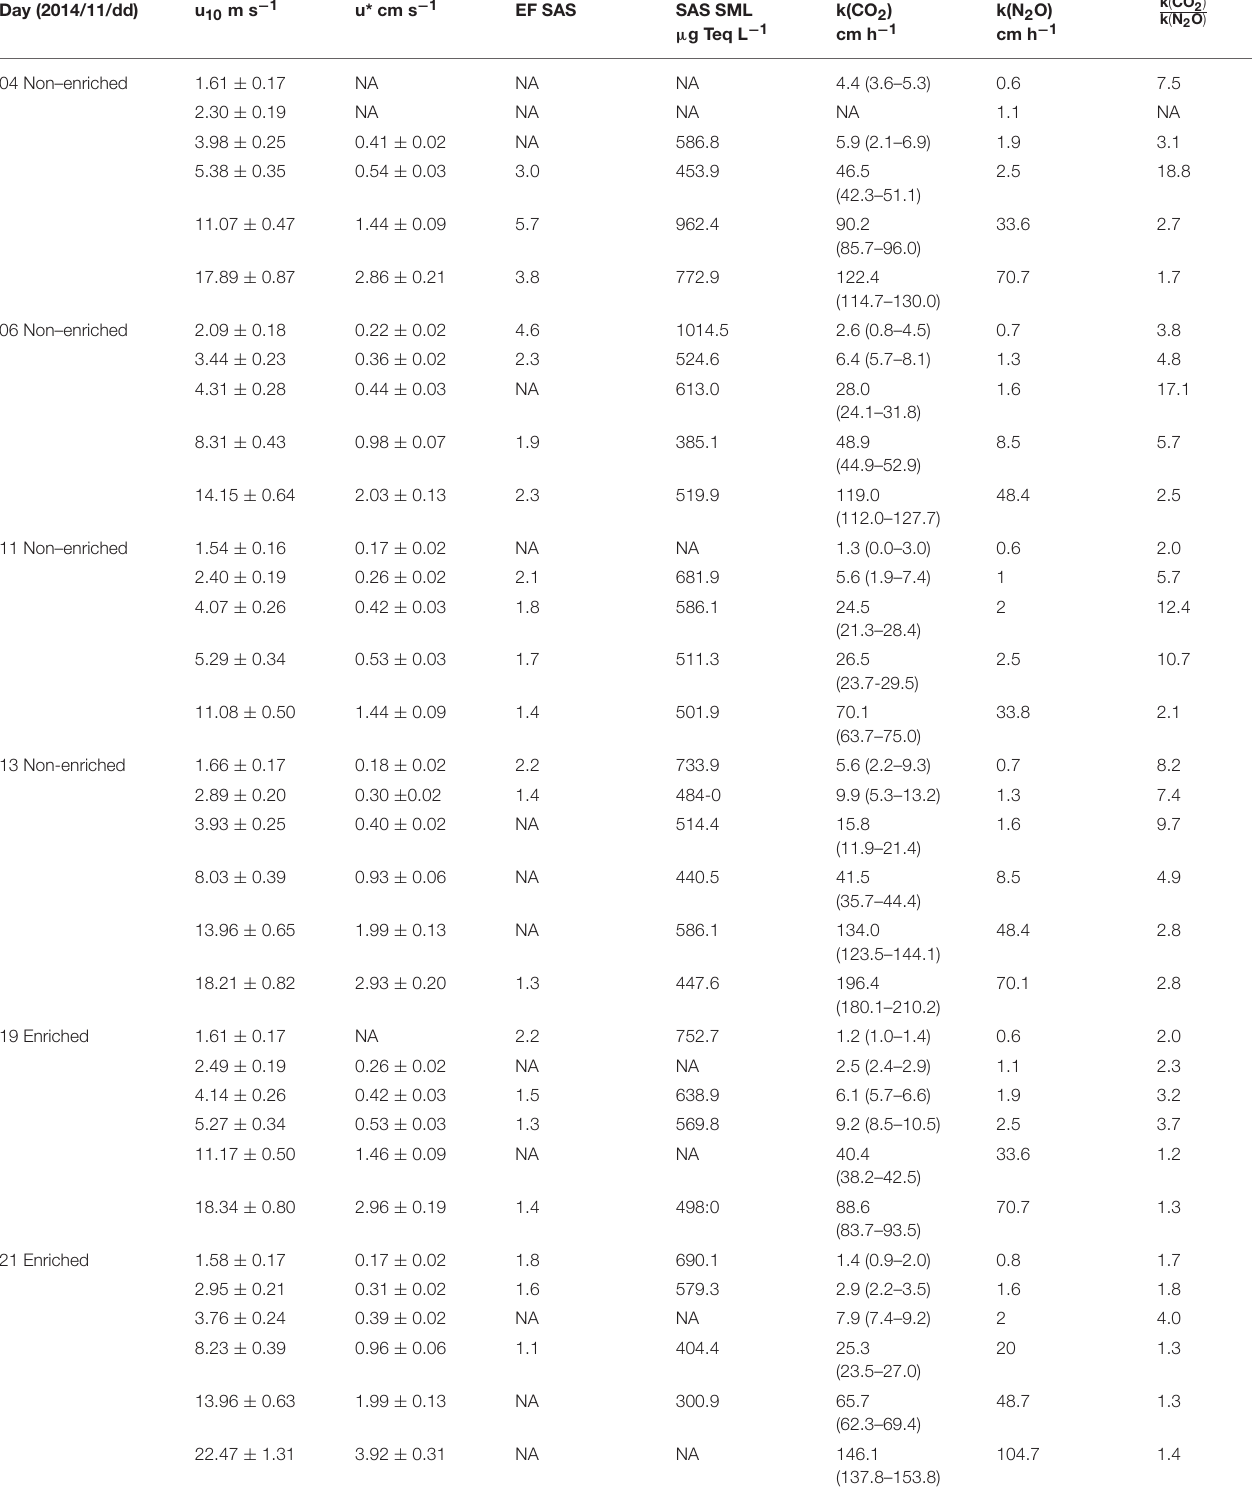
TABLE 1 | Day of the experiment and conditions (CO 2 enriched or non-enriched), wind speed u 10 , friction velocity (u*), enrichment factor of surfactants, surfactants in the sea surface microlayer, total water transfer velocities k measured in the Aeolotron wind-wave tank for CO 2 presented as mean (lower range–upper range), total water transfer velocities k measured in the Aeolotron wind-wave tank for N 2 O and the ratio between gas transfer velocities CO 2 with the gas transfer velocities N 2 O. Day